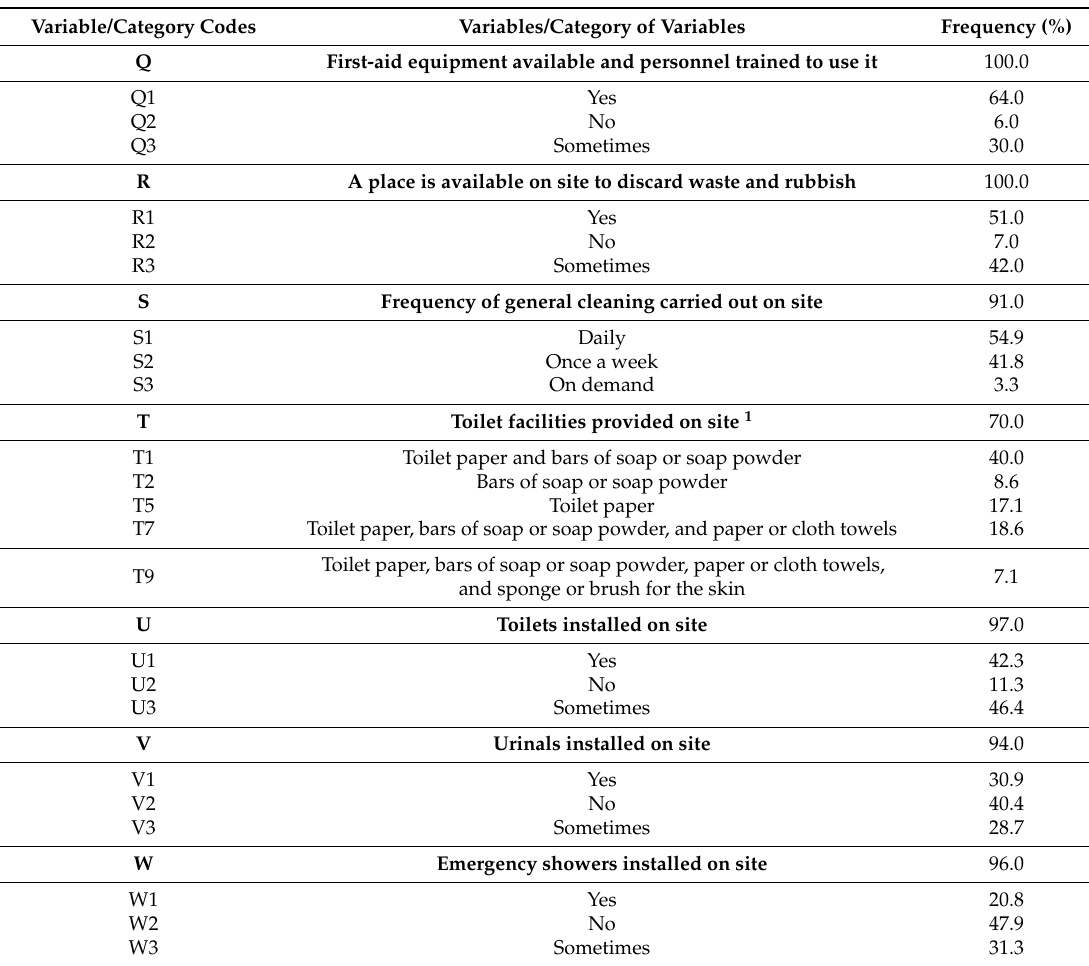
Table A3. Nomenclature and frequency of the categories of variables for Prevention Activities and Health and Safety Management in the company and on site (2nd